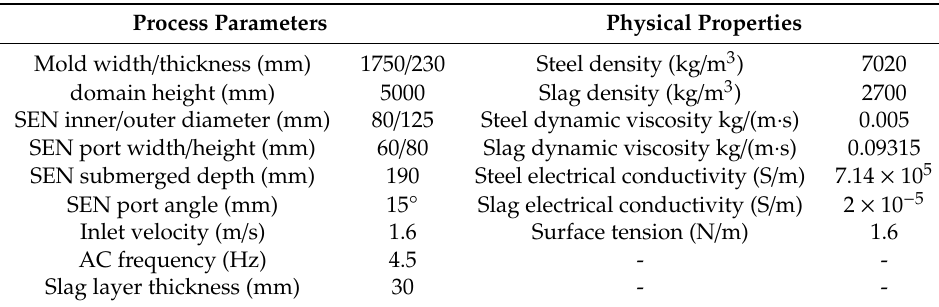
Table 1. The process parameters and physical properties of steel and slag.